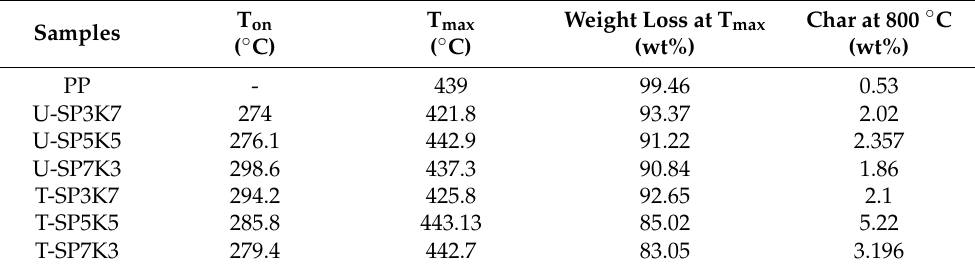
Table 2. Onset temperature, maximum temperature, weight loss, and maximum temperature and residual at 800 ◦ C, analyzed in TGA